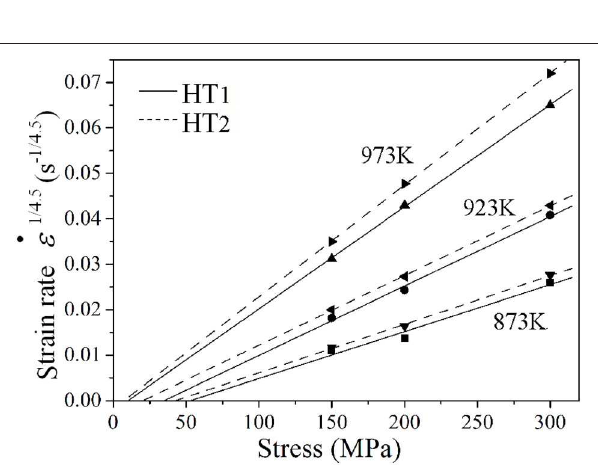
FIGURE 10 | Threshold stresses of TMCs after heat